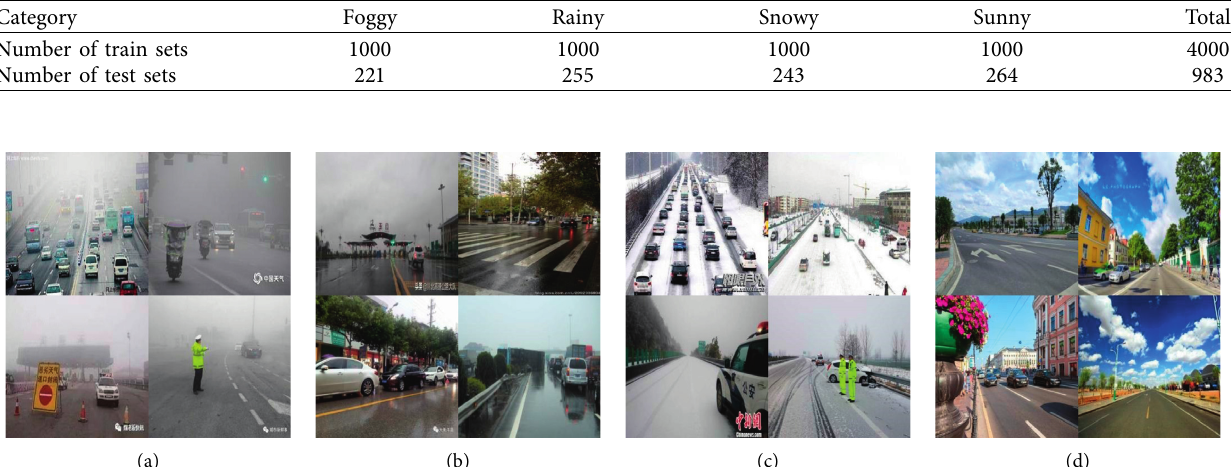
Table 1: Details of